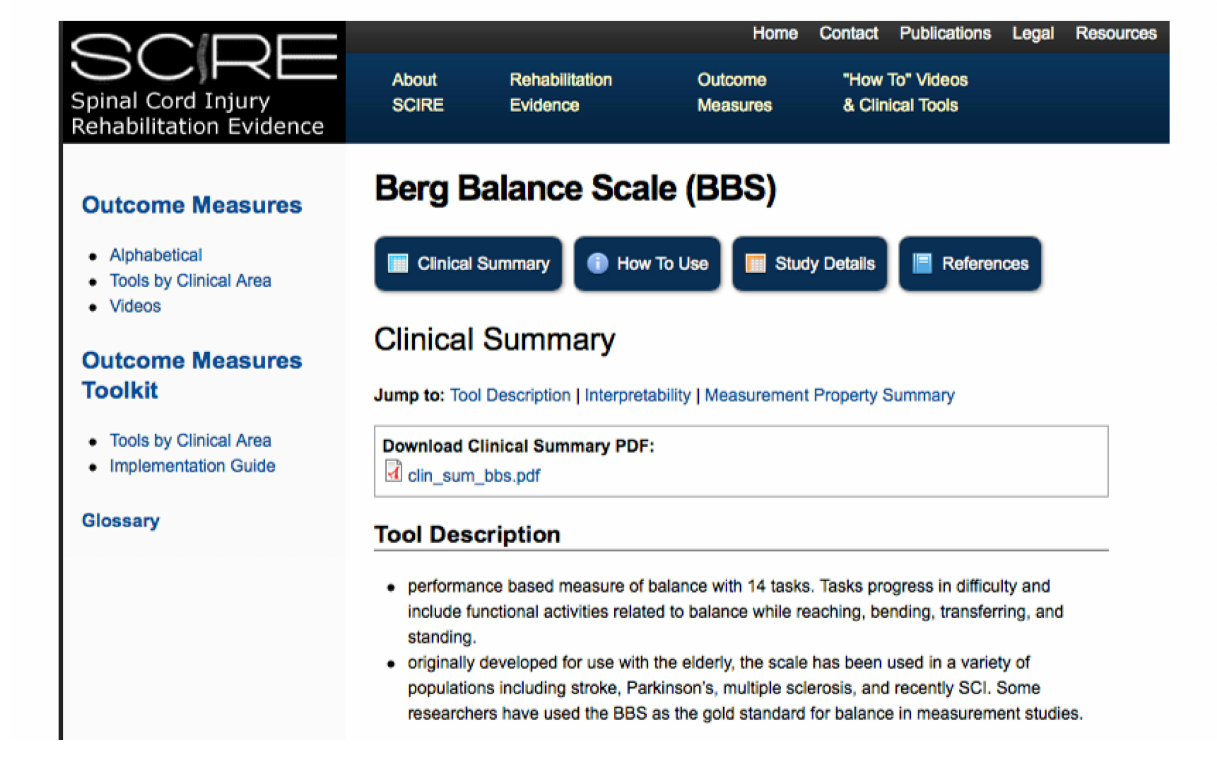
Figure 2. Screenshot illustrating one of the available 105 outcome measures related to spinal cord injury. For each outcome measure, a clinical summary and how-to-use section is